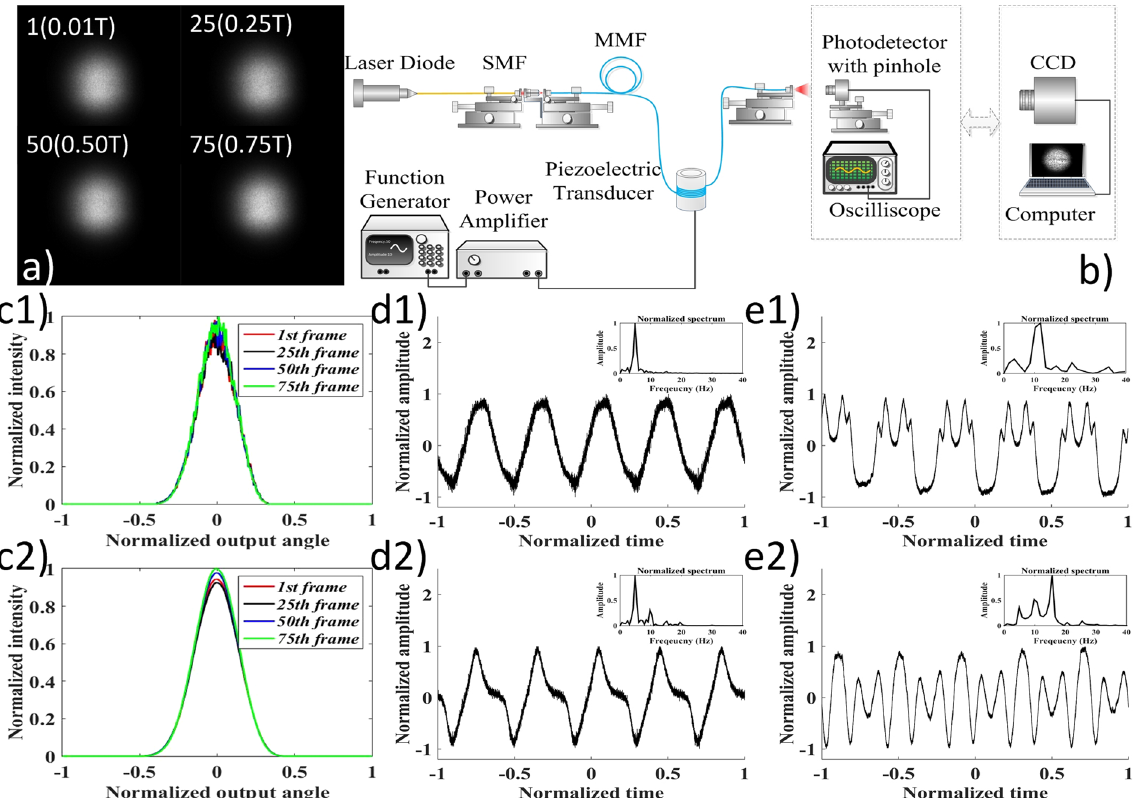
Figure 2. Experimental results of the angular power distribution of a large core multimode fiber under external perturbations. ( a ) shows the output images of 1 st , 25 th , 50 th , 75 th frames acquired by the CCD camera. 100 frames corresponded to a period (T) of perturbation. ( b ) shows the schematic experimental layout. ( c1 ) shows the intensity profile along the 512 th middle row of these four frames in ( a ). ( c2 ) shows the corresponding intensity profiles after smoothing the profiles in ( c1 ) in order to eliminate the sawtooth. The result indicated that the power coupling due to external perturbations is more efficient at the output center. ( d1 and d2 ) show two captured 5 Hz signal by photodetector module. ( e1 and e2 ) show two captured signals when drive voltage was increased to 100 Vpp. The 5 Hz and harmonics (10 Hz, and 15 Hz) signals were detected. The insets in ( d1 , e1 , d2 and e2 ) are the frequency spectra corresponding to the temporal